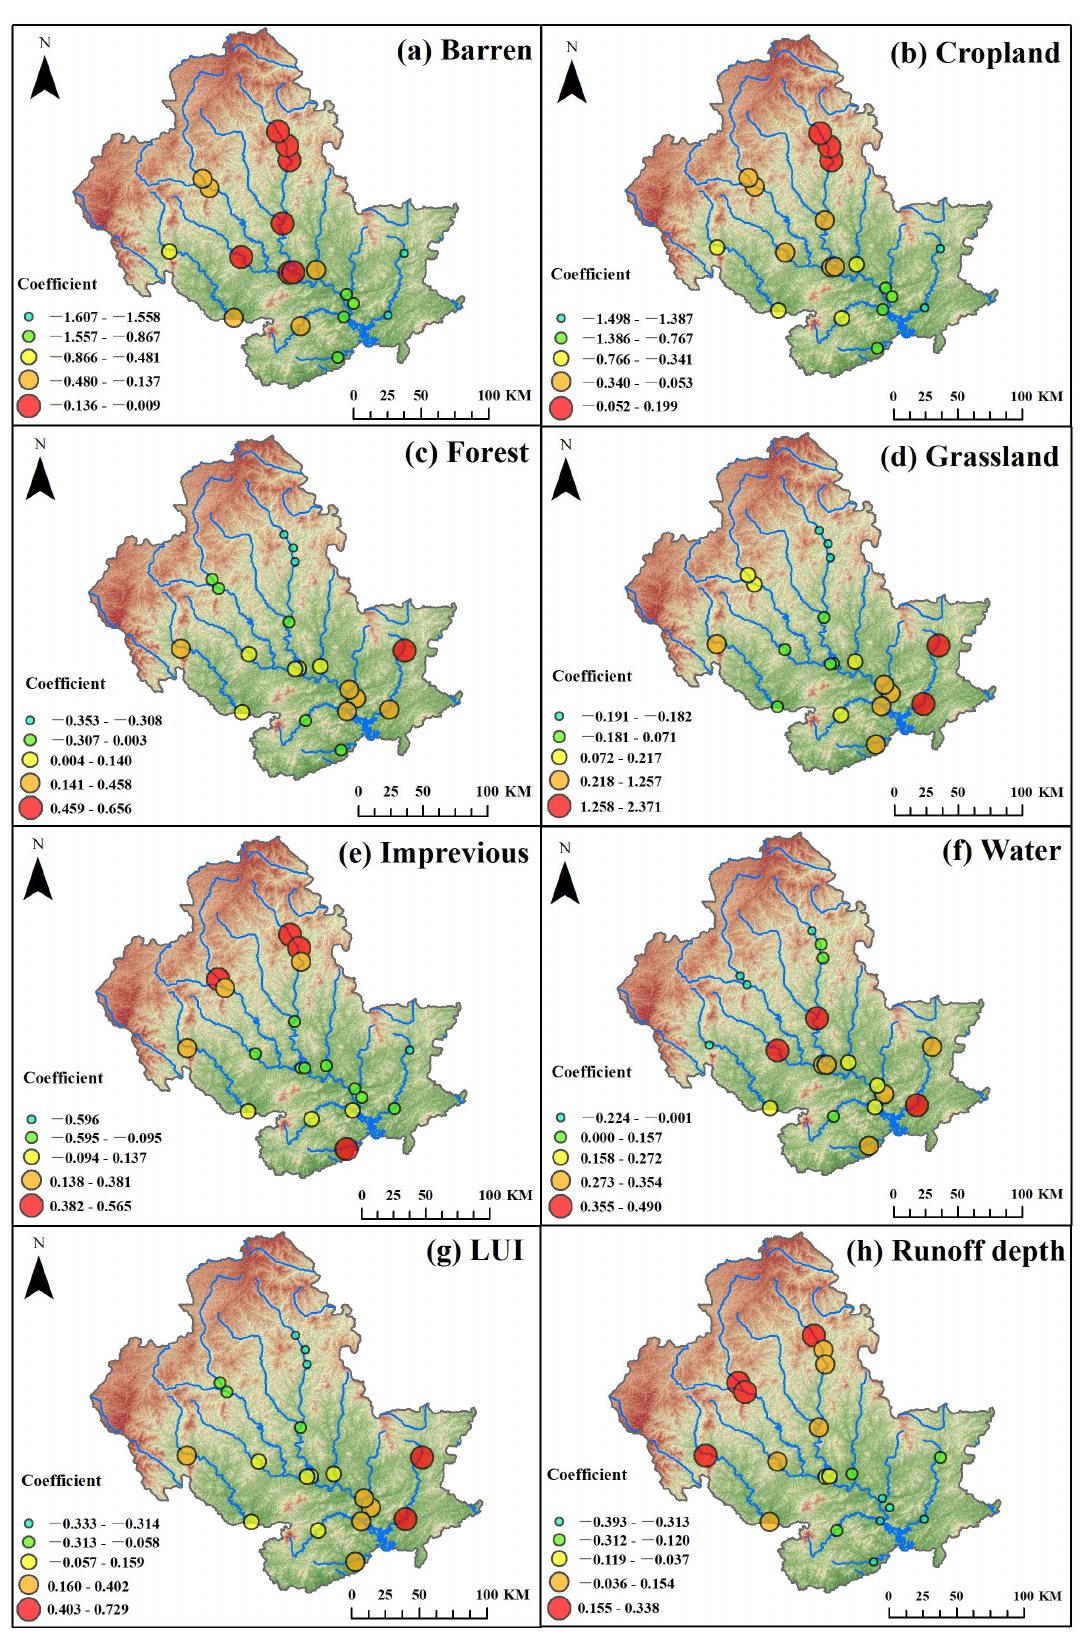
Figure 4. Geographically and temporally weighted regression between land use and runoff in